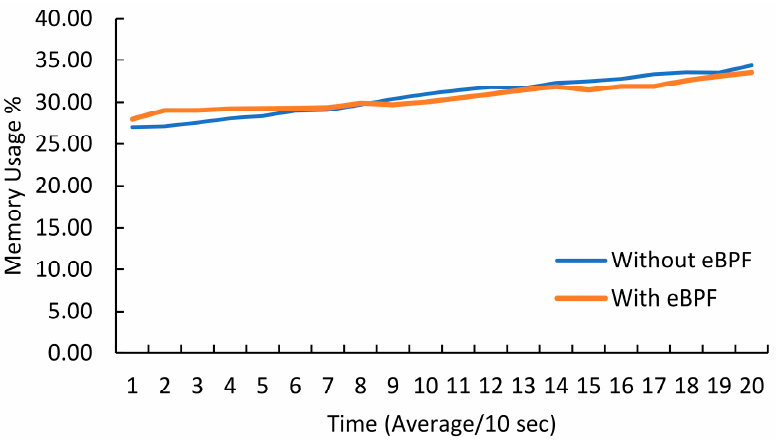
Figure 6. Master Node Memory Overhead Analysis.